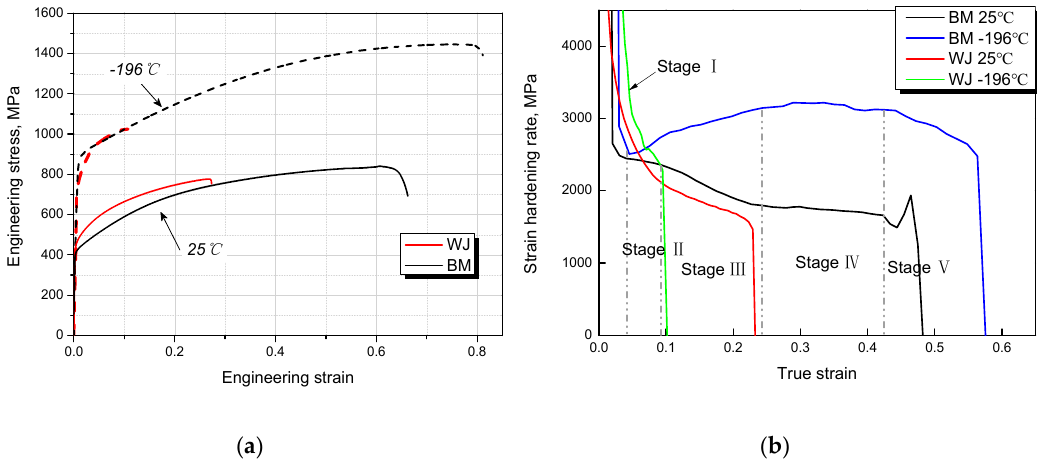
Figure 3. ( a ) Engineering stress-strain curves, ( b ) strain hardening rate curves of WJ and BM at room temperature and − 196 °C.